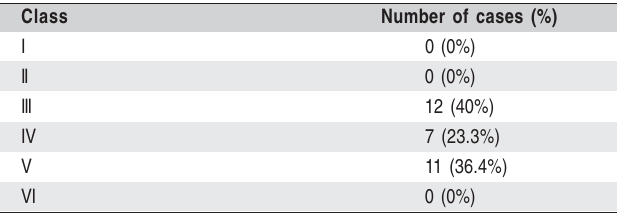
Table 1. Distribution of the bone sections studied according Cawood and Howell (1988) 9 edentulous jaws classification.